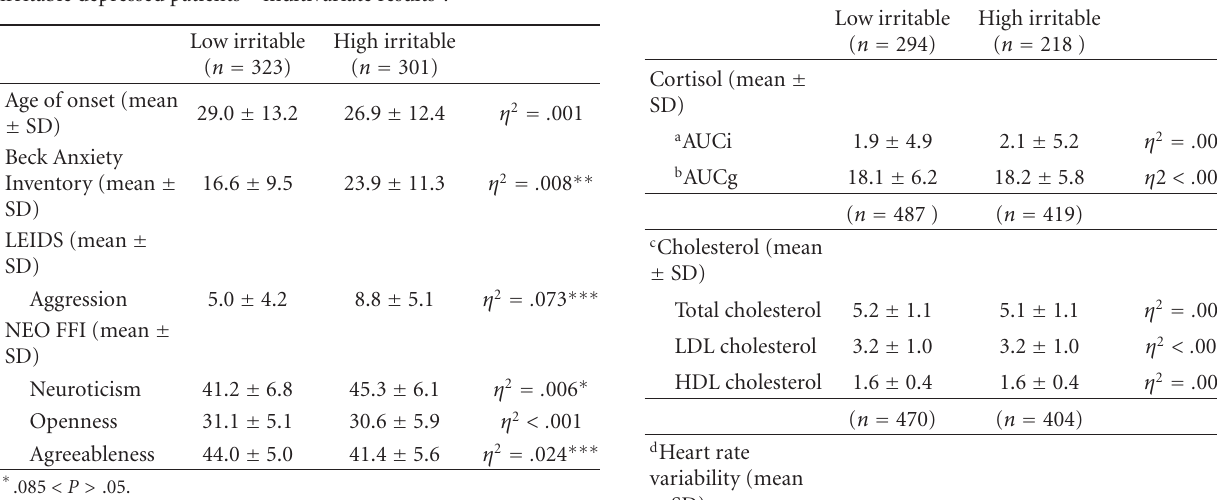
Table 3: Psychophysiological